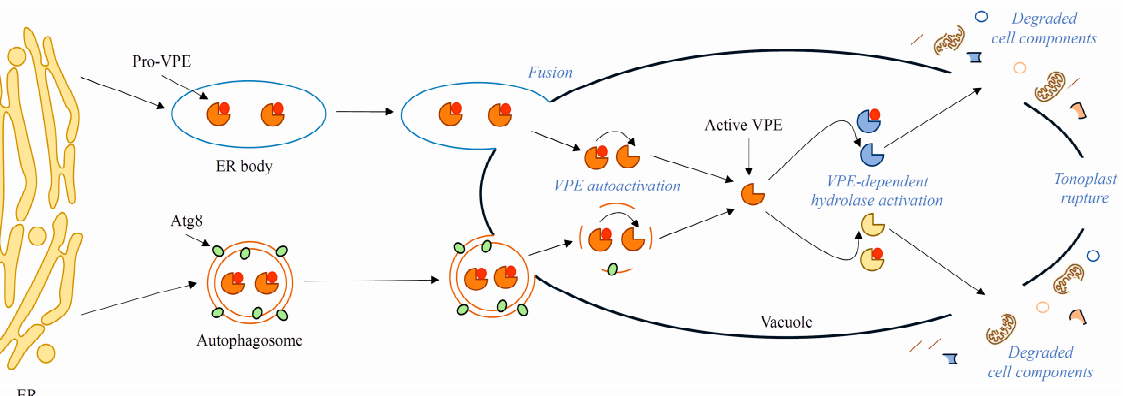
Figure 3. Possible ways of transport of VPEs in plant cells. Premature VPEs are synthesized in the endoplasmic reticulum (ER) and then are translocated to the vacuole through spindle-shaped ER bodies with single membranes or through autophagy inside autophagosomes tagged with Atg8. After fusion with the tonoplast, pro-VPEs are subjected to autoactivation in acidic pH inside the vacuole. It is presumed that mature VPEs process other vacuolar hydrolases, which contribute to tonoplast rupture and cell death.